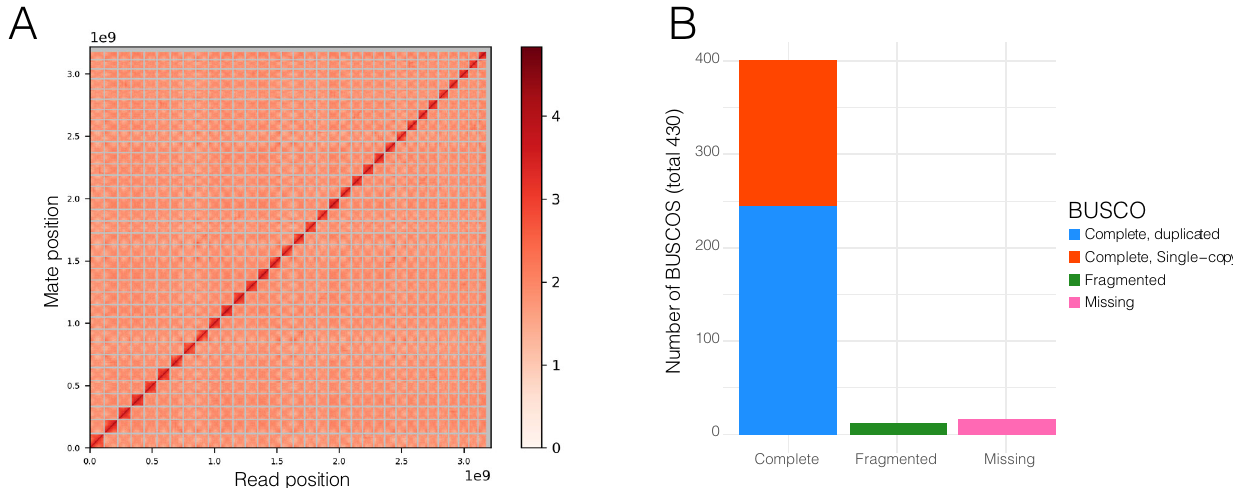
Fig. 1 Chromosome-resolved assembly of the Scalesia atractyloides nuclear genome. A Link density histogram, with 34 linkage groups (chromosome models) identi fi ed by contiguity ligation sequencing. The x and y axes show mapping positions of the fi rst and second read in read pairs. B Viridiplantae BUSCO set, which offers a characterisation of conserved orthologue